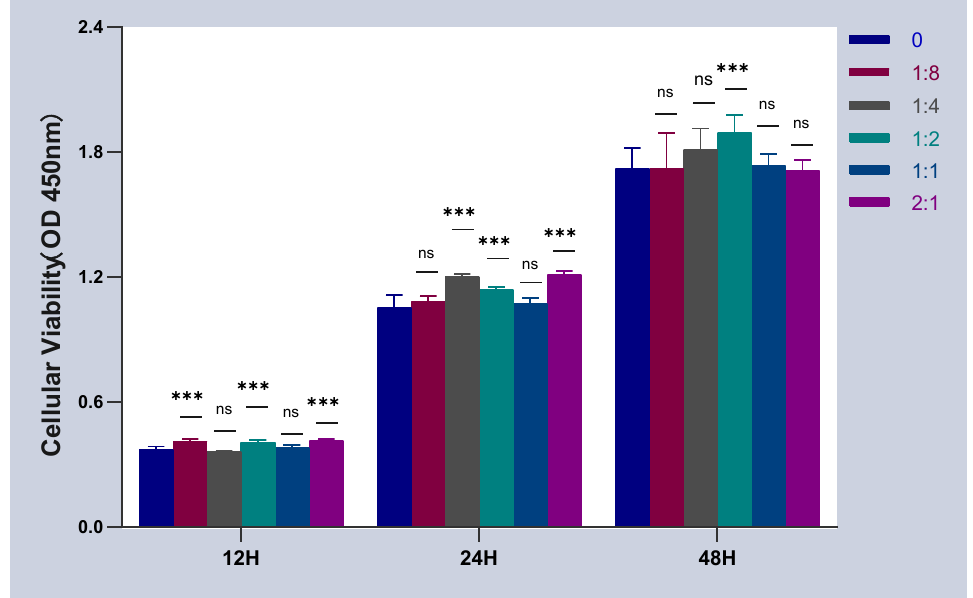
Figure 1. The cell activity curves of HSFs, when HSFs were cell co-cultured with HVECs. ns: p > 0.05, ***: p < 0.001.